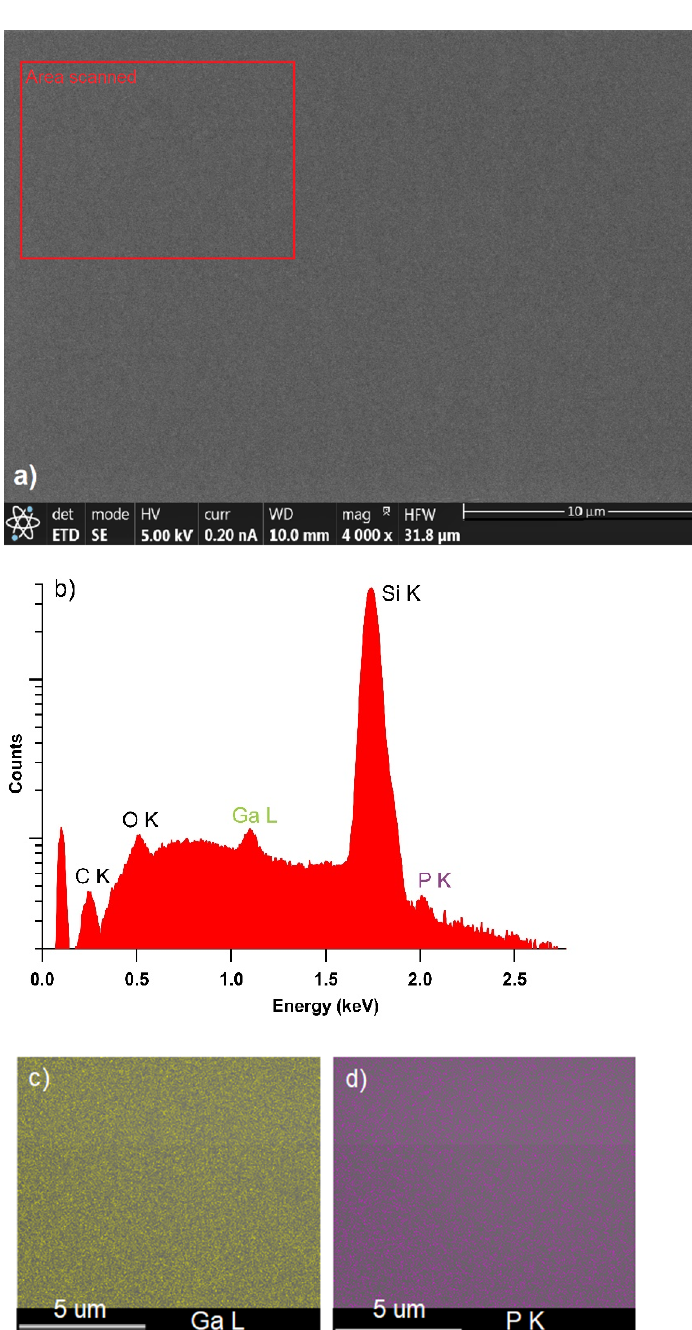
Figure 6. ( a ) SEM image of 30 µ m × 30 µ m; ( b ) EDX spectra from scanned area; ( c , d ) color maps from scanned area that represent Ga and P signals, respectively.